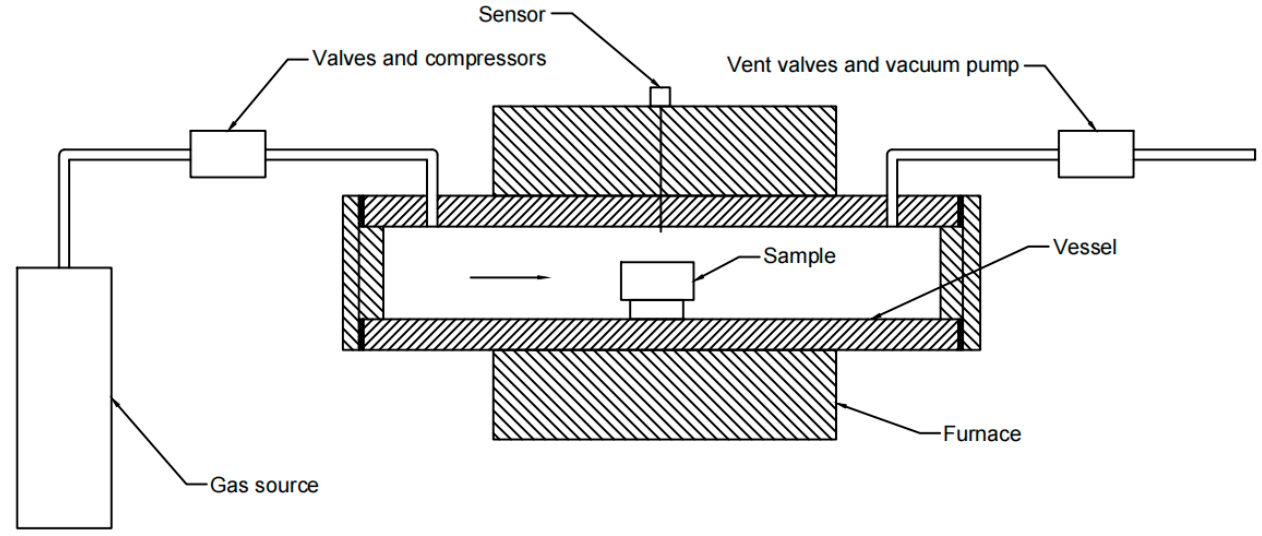
Figure 2. Schematic diagram showing the main structure of a flow overpressure system.